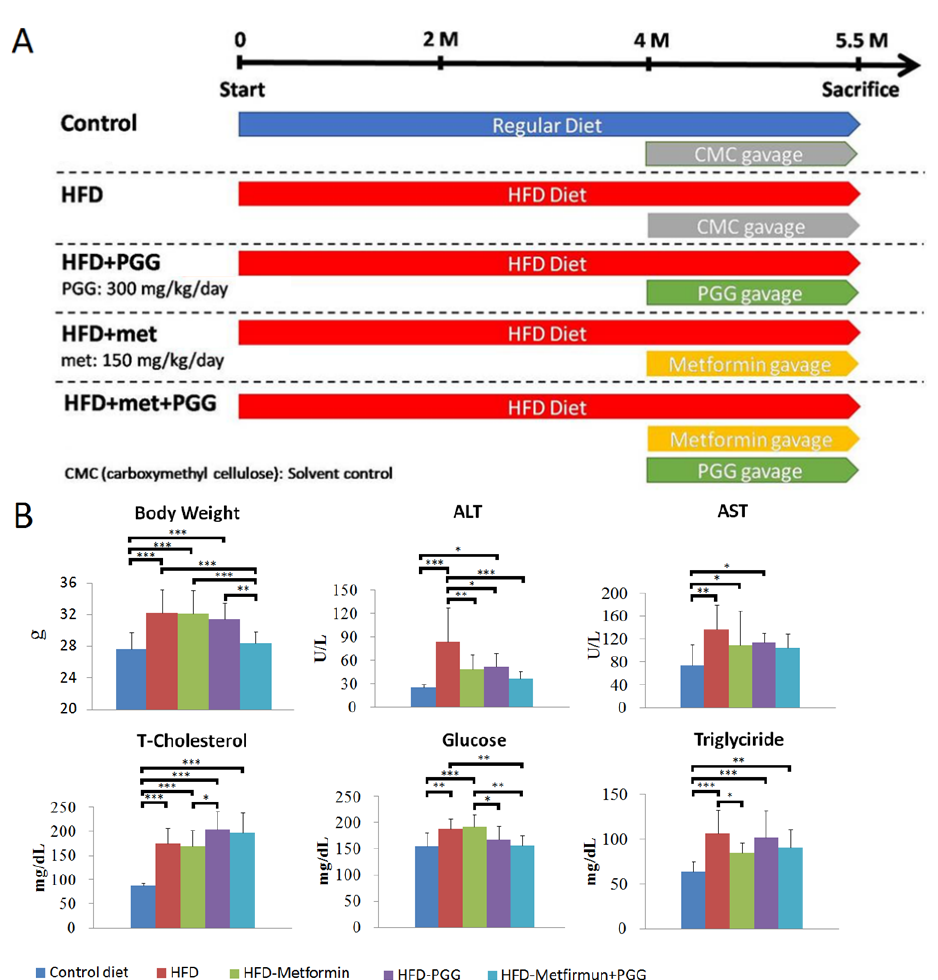
Figure 1. Body weight and biochemistry data of five groups of mice with indicated treatment. ( A ) The study design for the imitation of NAFLD. ( B ) Body weight and the values of serum biochemistry including ALT, AST, triglyceride, cholesterol and glucose were examined at the end point. (* p < 0.05; ** p < 0.01; *** p < 0.001; N =